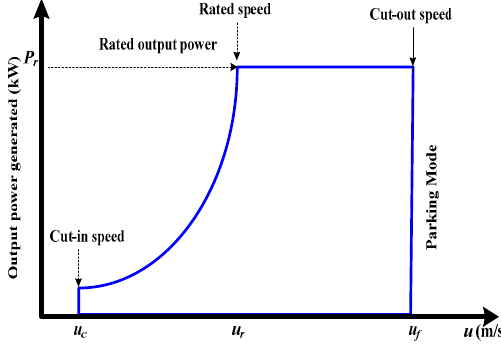
Figure 6. The wind turbine output power characteristics .